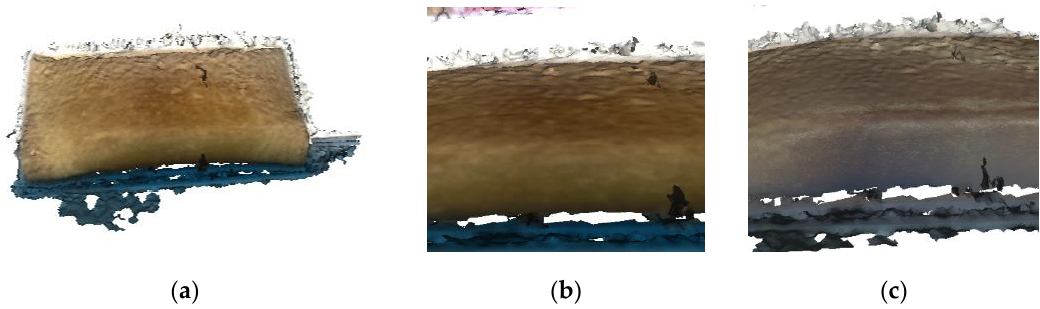
Figure 15. ( a ) Model after surface reconstruction. ( b ) Model before texture image creation. ( c ) Model after texture image creation. The model after surface reconstruction, the model before and after texture creation.